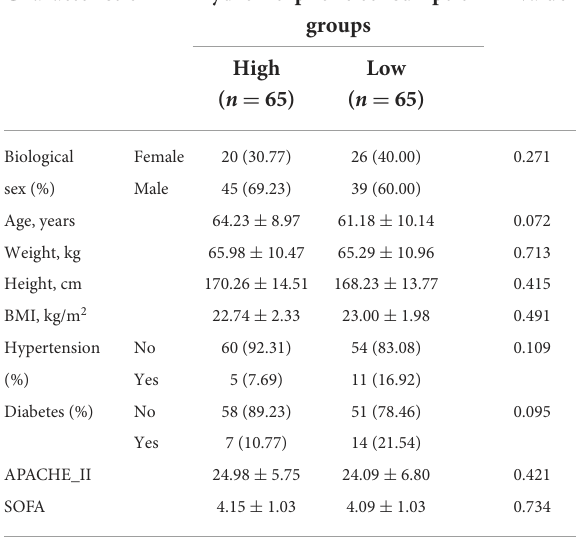
TABLE 1 Comparison of baseline characteristics between the two hydromorphone consumption